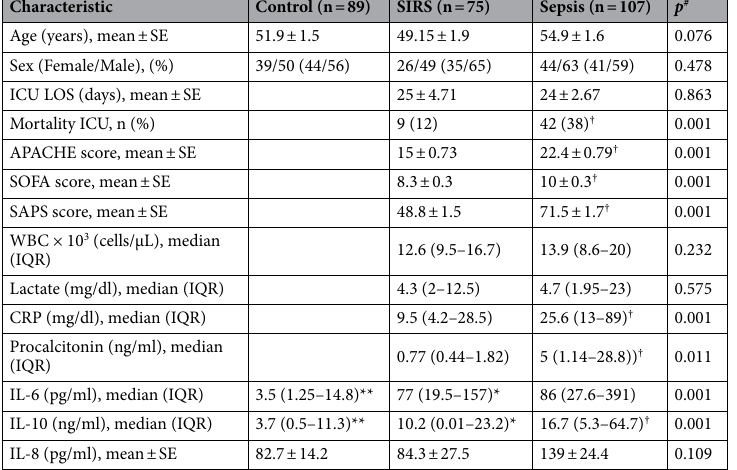
Table 1. Mortality, disease severity scores, heart rate, CRP, and lactate were higher in sepsis compared to trau- matic SIRS ( p < 0.05). Survivin transcriptional expression and survivin/caspases serum concentrations. Serum lev- els of the survivin wild-type protein were elevated in septic patients compared to traumatic SIRS and control individuals ( p < 0.001) (Fig. 1). Survivin-WT and splice variant -ΔΕx3 were the dominant isoforms, showing the highest levels of expression in patients’ samples. The -2B, -ΔΕx3 and -WT transcriptional levels were increased in sepsis compared to controls and/or SIRS ( p < 0.001), whereas survivin-3B was repressed in sepsis compared to SIRS ( p = 0.028) (Fig. 2a–d). A concurrent upregulation of total (pro-caspase, active and cleaved) caspase-3 and